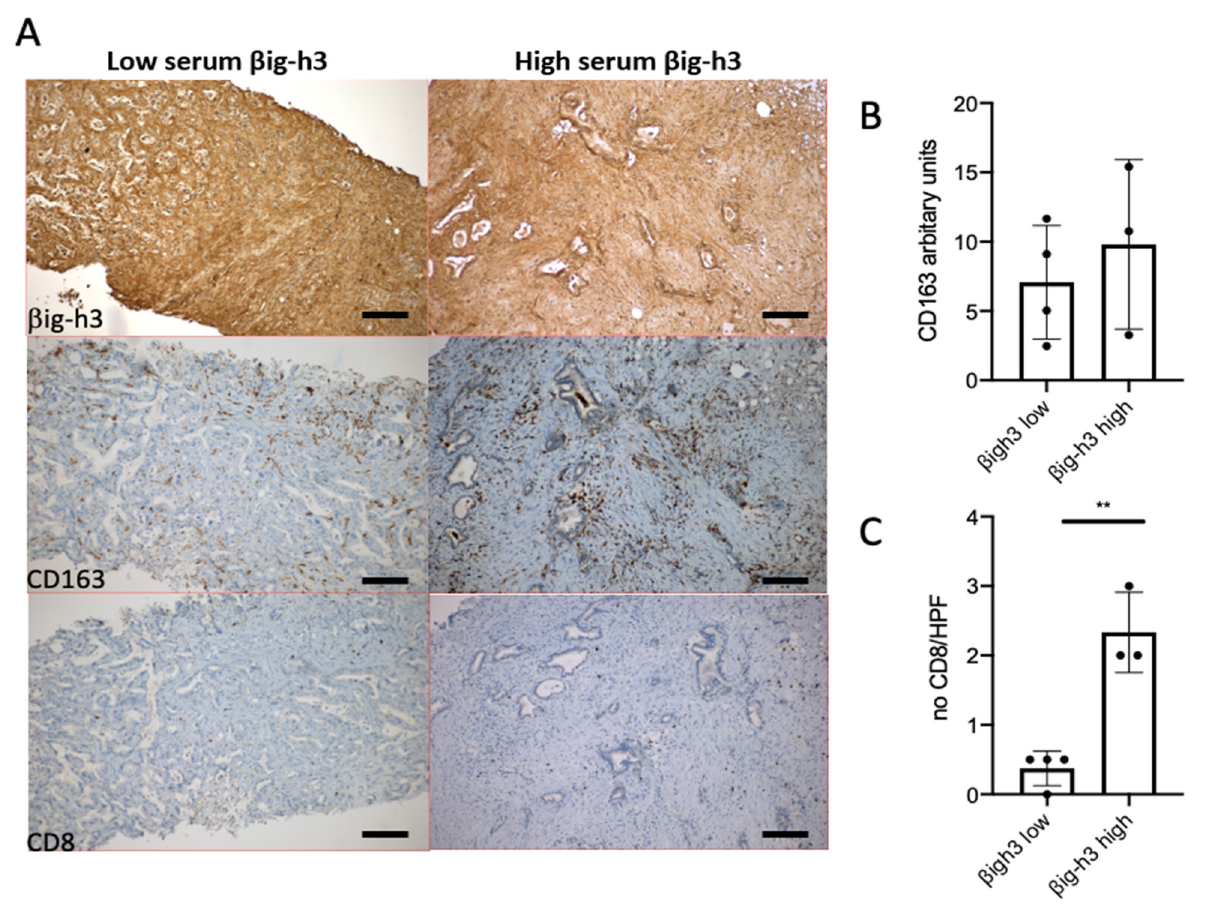
Figure 2. β ig-h3, CD163, and CD8 staining in pancreas biopsies. ( A ) Immunohistochemistry staining of pancreatic biopsies for 2 patients with low and high β ig-h3 serum levels stained for β ig-h3, CD163, and CD8. Quantification of the CD163 staining area ( B ) of CD8 + T cells number ( C ) and in 7 patients. ** p < 0.01. HPF: high-power field. Scale bar 100 μ m.